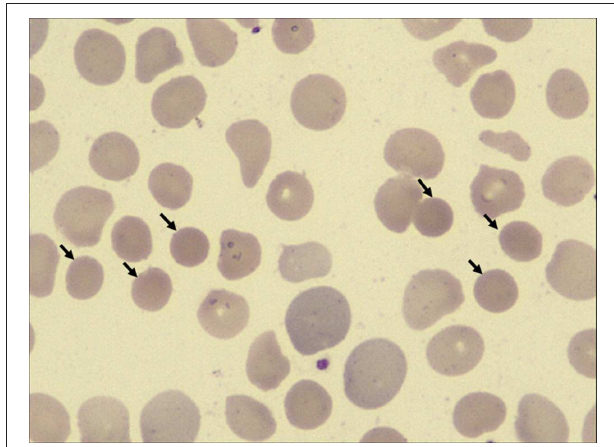
FIGURE 1 | High-power view ( × 100 magnification) of peripheral blood smears from the patient. Spherocytes are indicated by black arrows.